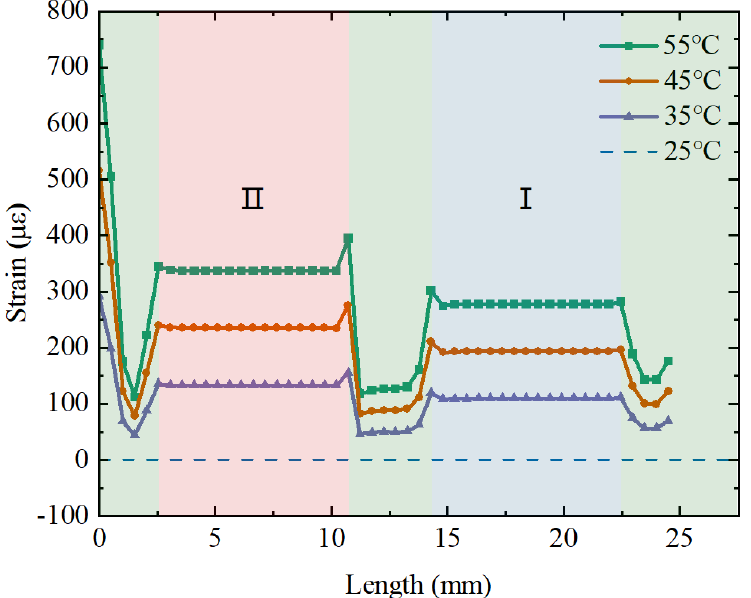
Figure 5. The relation between the applied temperature and the strain distribution along the sus- pended